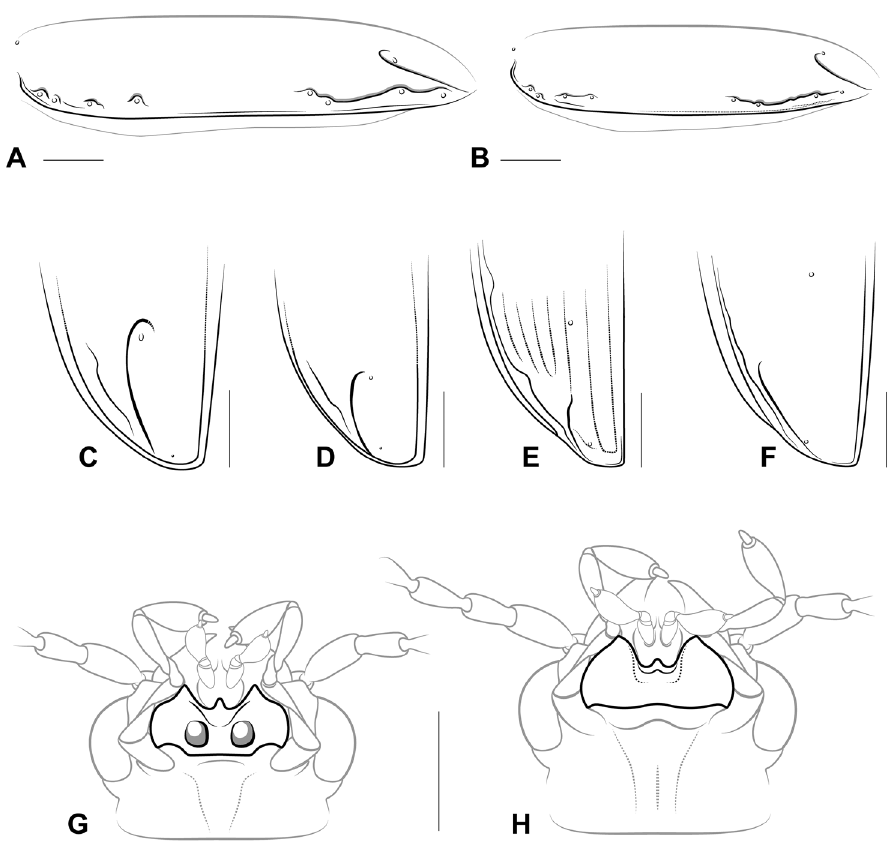
Figure 1. Basic characters for generic and subgeneric level identification of Tachyina. A–B Left elytron, lateral view, illustrating positions of elytral ombilicate setae and form of the 8 th elytral interneur (other interneurs omitted) A Paratachys fulvicollis ; B Tachys vittiger C–F Elytral apex C Paratachys fulvicollis D Tachys vittiger . Scale bar 0.25 mm E Elaphropus ( Ammotachys ) marchantarius F Tachyxysta howdenorum G–H Head, ventral view, illustrated to show mentum G Meotachys ( Scolistichus ) riparius H Elaphropus ( Barytachys ) nebulosus . Scale bars = 0.25